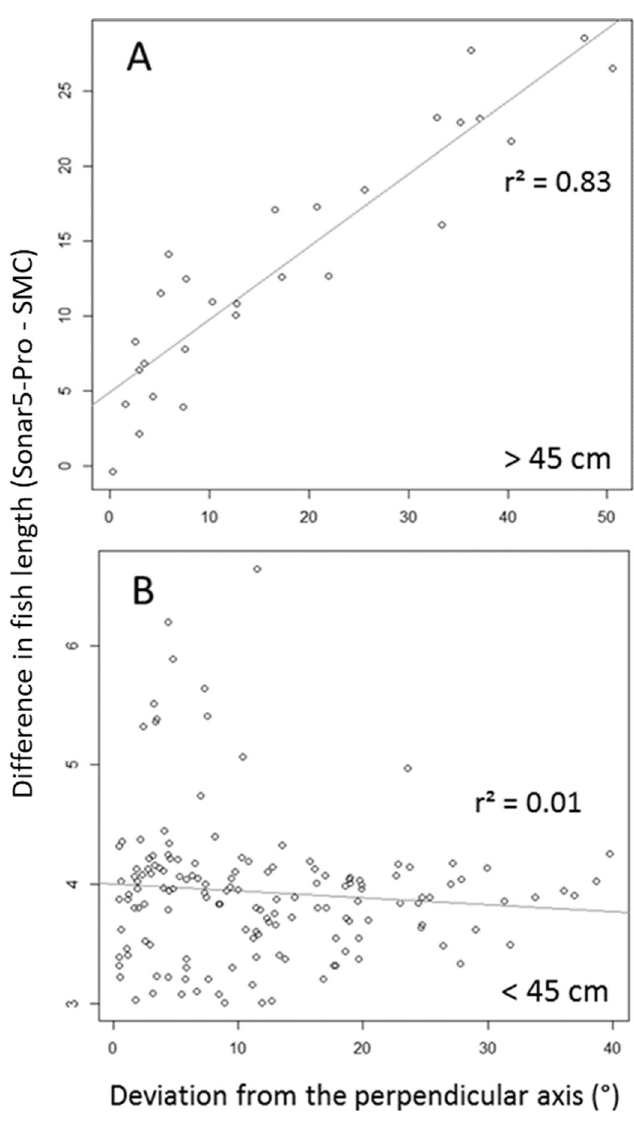
Fig. 8. Evaluation of the in fl uence of fi sh body orientation deviating from the perpendicular beam axis (degrees) on the accuracy of estimated length by Sonar5-Pro, as a function of manually measured fi sh length. (A) fi sh < 45 cm ( n =152); (B) fi sh > 45 cm ( n